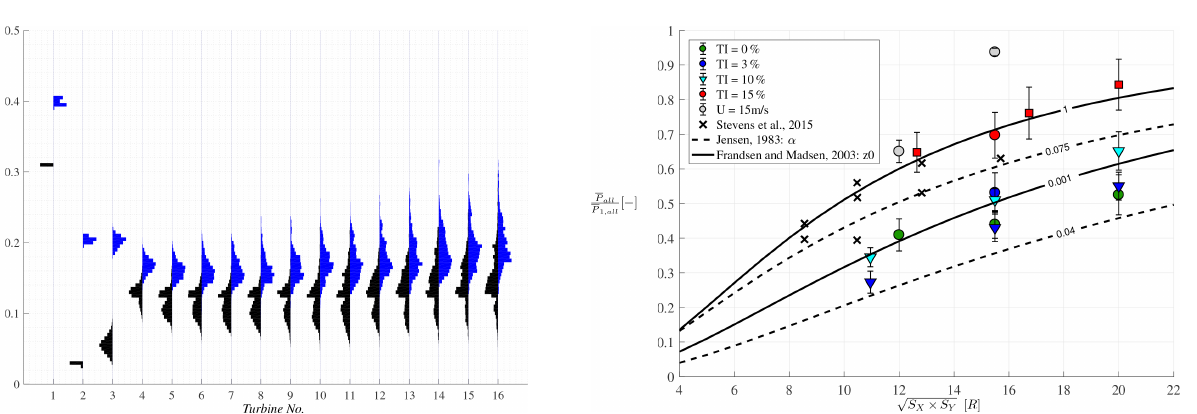
Figure 6. Violin plots comparing the influence of turbine spac- ing on the instantaneous power production in DTU5 (black) with S X × S Y = 12 R × 12 R and DTU7 (blue) with S X × S Y = 14 R × 14 R , where no ambient turbulence intensity has been applied.